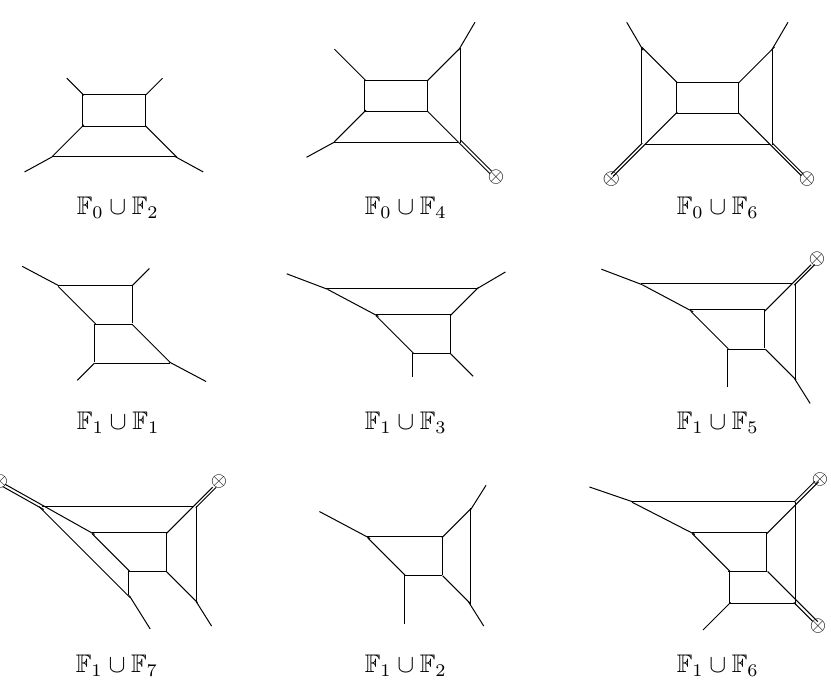
Figure 8. Brane con(cid:12)gurations of rank 2 SCFTs with M =